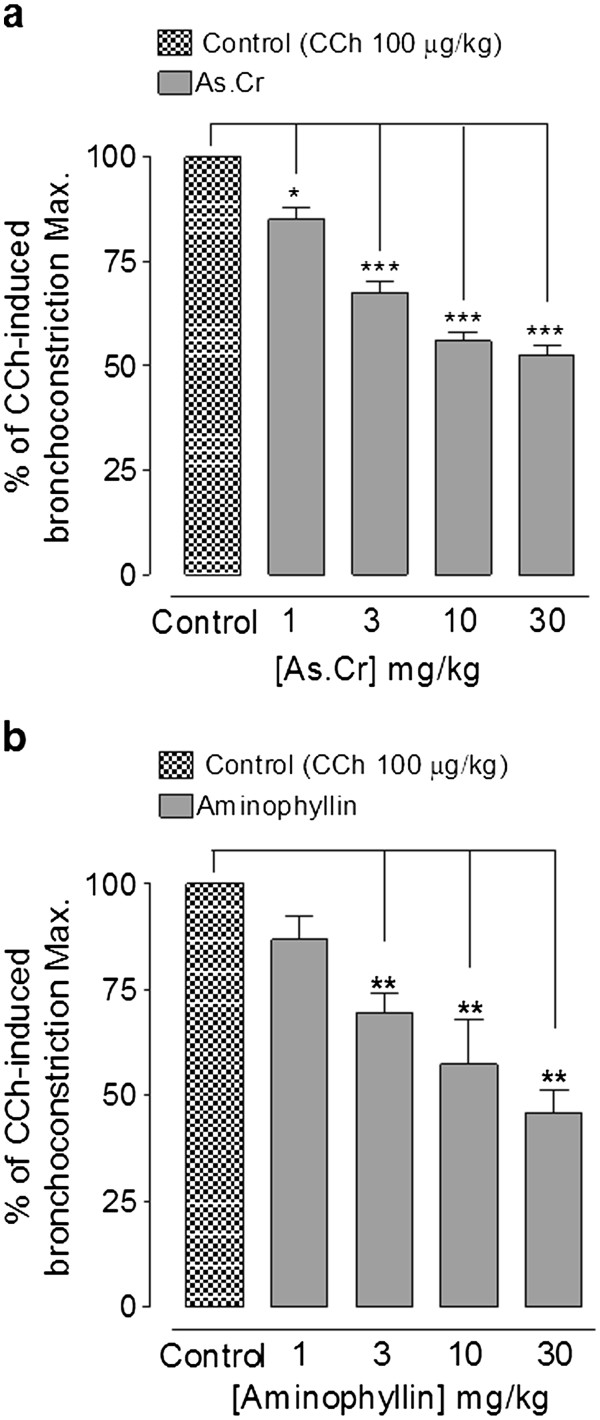
Dose-dependent inhibitory effect of(a) the crude extractofA. spinosus(As.Cr) and (b) aminophyllineon carbachol (CCh)-induced bronchoconstrictionin anaesthetized rats. Values shown are mean ± S.E.M, n = 4–6, *P < 0.05, **P < 0.01, ***P < 0.001 vs. control (CCh), One-way ANOVA, followed by Dunnett’s test.